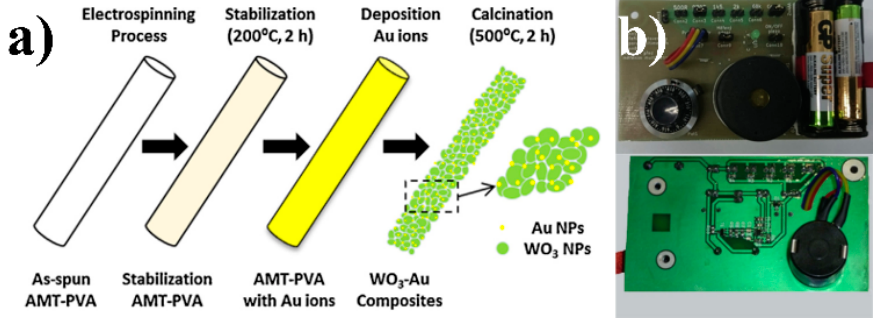
Figure 6. Fabrication of NP interfaces for electronic sensors: ( a ) The formation of tungsten oxide (WO 3 )-Au composites nanofibers [108], copyright 2015 Elsevier Ltd; ( b ) front and back side snapshots of proposed comparator [111], copyright 2016 Elsevier Ltd.